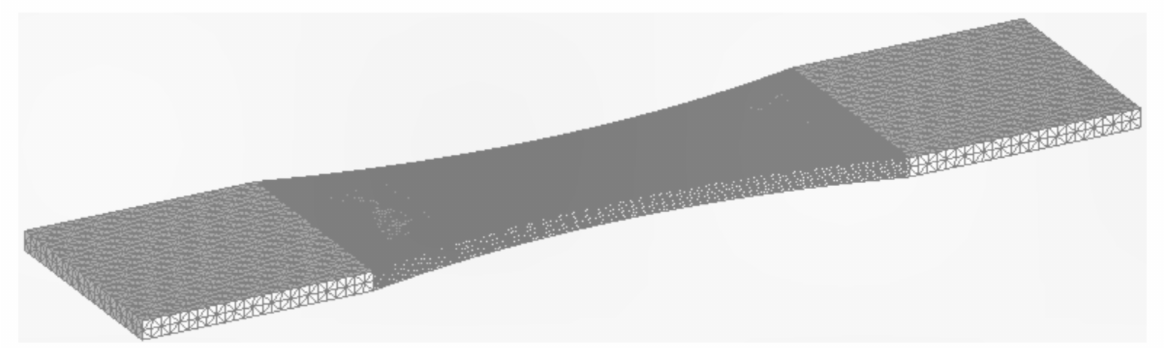
Figure 14. Mesh 2: 511,747 ten-noded iso-parametric tetrahedral elements and 755,061